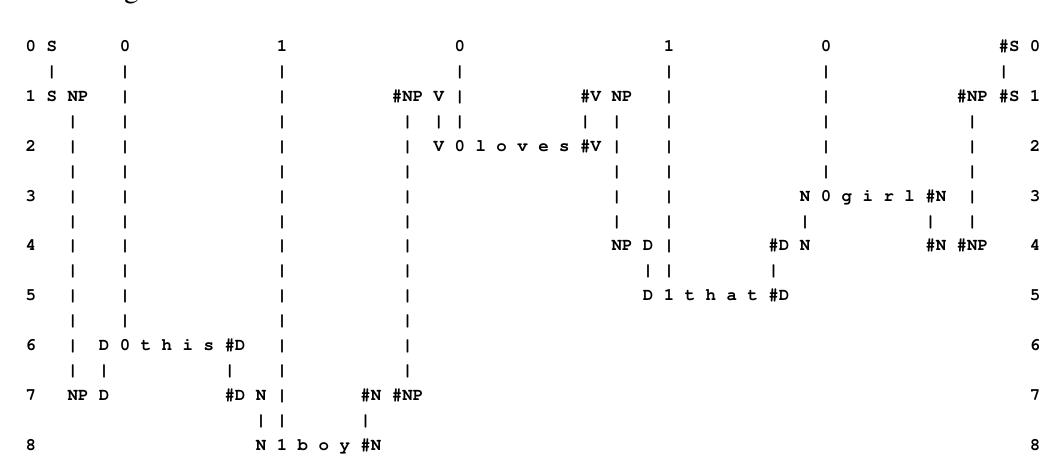
Figure 7. The best multiple alignment found by the SP model with the New pattern, “ S 0 1 0 1 0 #S ”, and the same Old patterns as were used to create the multiple alignment shown in Figure